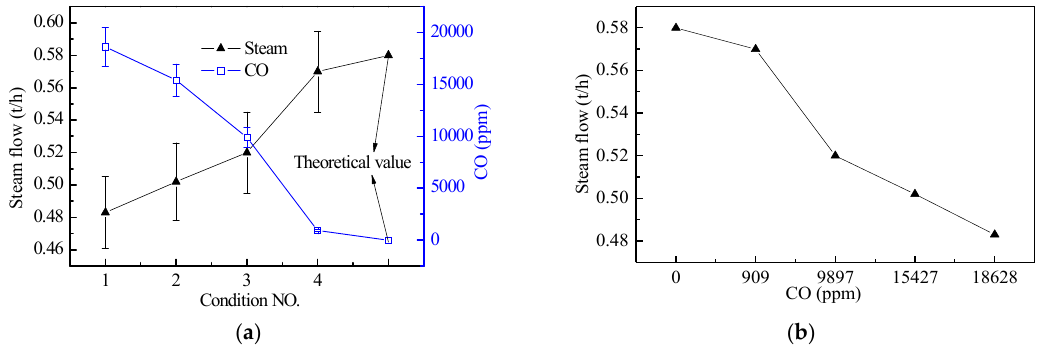
Figure 9. ( a ) Effects of combustion conditions on steam production and CO concentration, and ( b ) the relationship between steam production and CO.